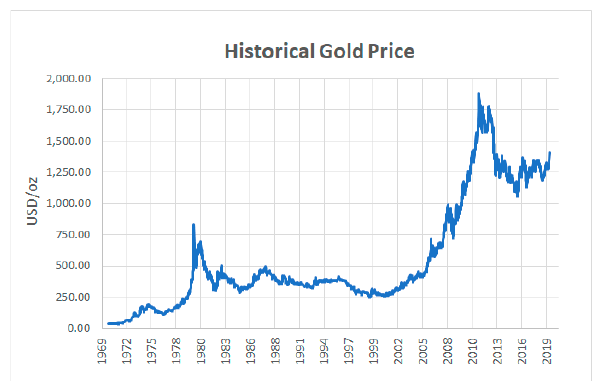
Figure 2. Price of gold from 1970 to